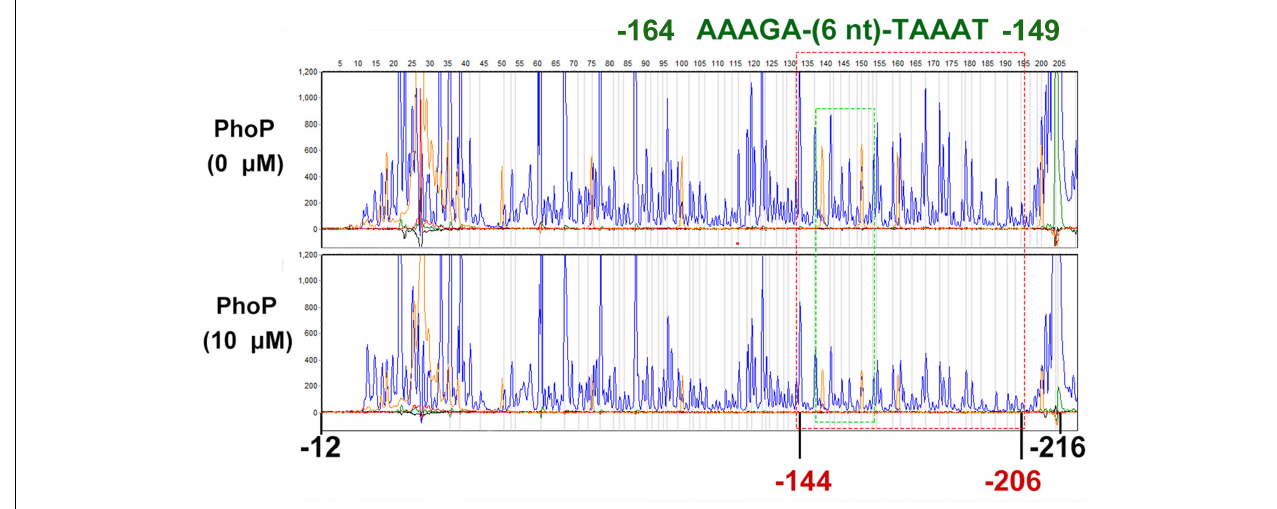
FIGURE 4 | DNase I footprinting assays for mapping the binding sequence recognized by PhoP. FAM-labeled primer-based DNase footprinting experiments. Protection of the folA promoter DNA against DNase digestion by phosphorylated PhoP (10 µ M) was evaluated. The sequences of the protected regions on the non-coding strand are framed in the figures. The fluorescence signal faded out obviously from position − 144 to the end of the strand, but not completely disappeared (Dotted red box). Dotted green box contains a tandem repeat sequence AAAGA-(6 nt)-TAAAT ( − 164 to − 149). The experiment was repeated at least three times and a representative result was presented.